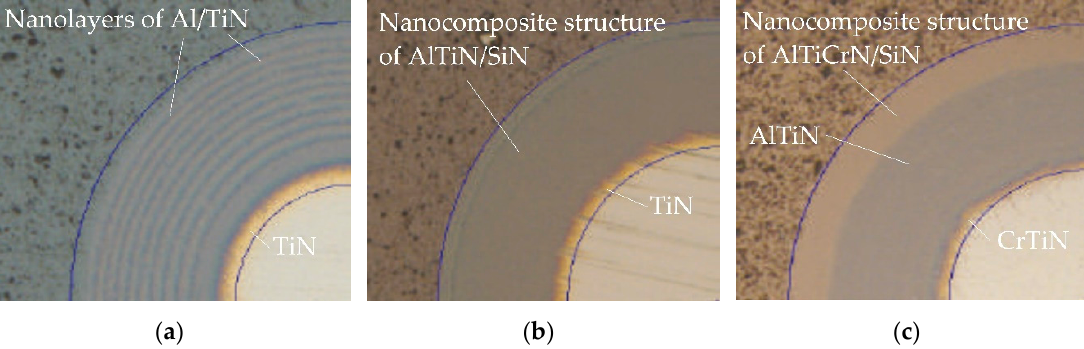
Figure 5. Images of the composition number of layers of the formed multi ‐ component coatings of various compositions by analysis on a Calotest instrument: ( a ) TiN–Al/TiN; ( b ) TiN–AlTiN/SiN; ( c ) CrTiN–AlTiN–AlTiCrN/SiN.